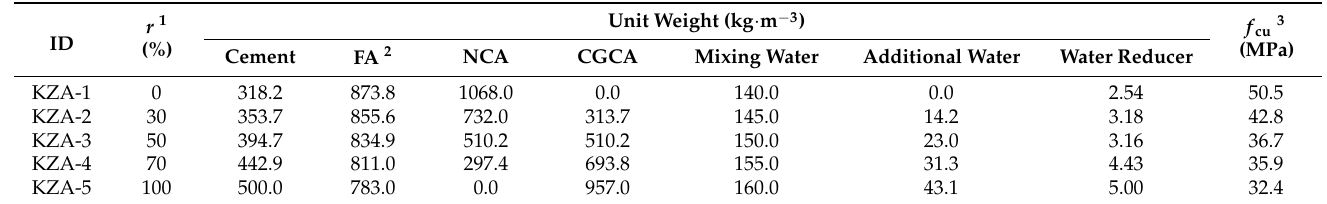
Table 2. Mix proportion of concretes.